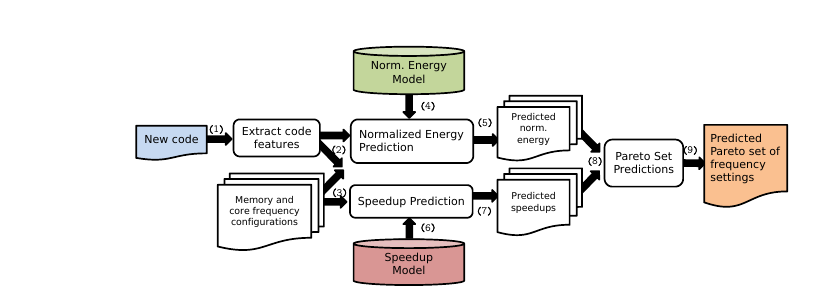
Figure 3. Training phase.